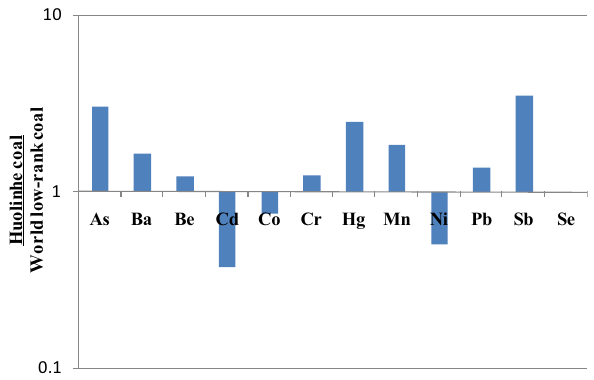
Fig. 6 Comparisons between the concentrations of trace elements in Huolinhe coal and those in world low-rank